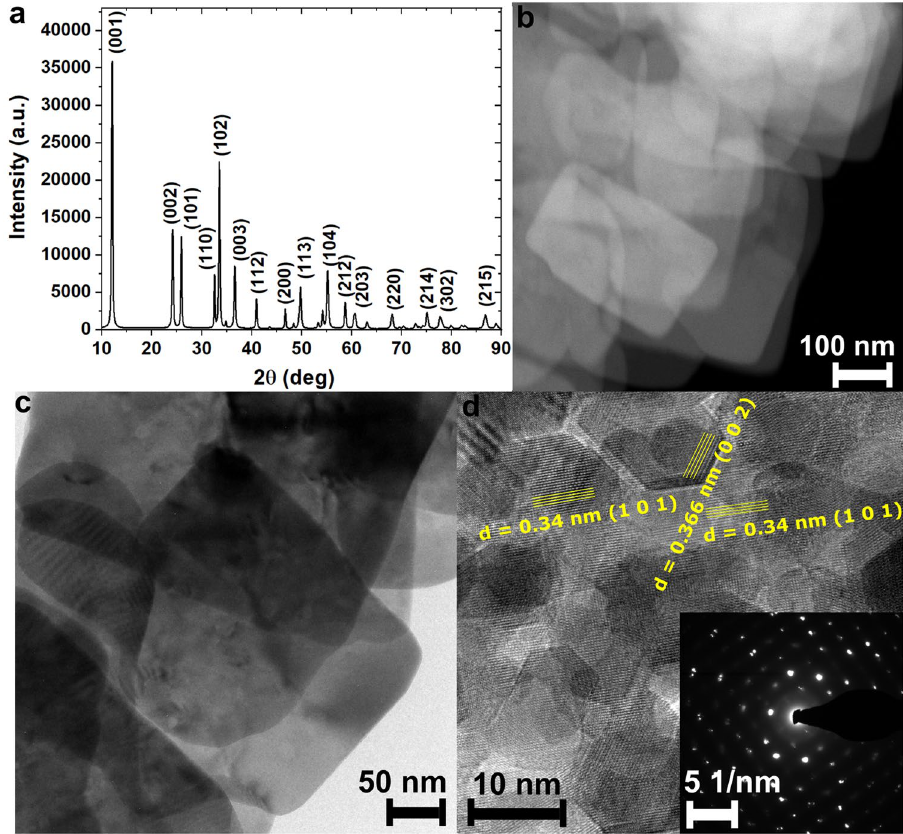
Figure 1. Structure and morphology of BiOCl plates: ( a ) XRD pattern of as-synthesized BiOCl using chloramine-T with marked Miller indices for peaks with the highest intensities; ( b ) HAADF STEM and ( c ) BF-DF STEM images of BiOCl; ( d ) TEM image of BiOCl plate with marked planes characteristic of BiOCl; inset shows the SEAD